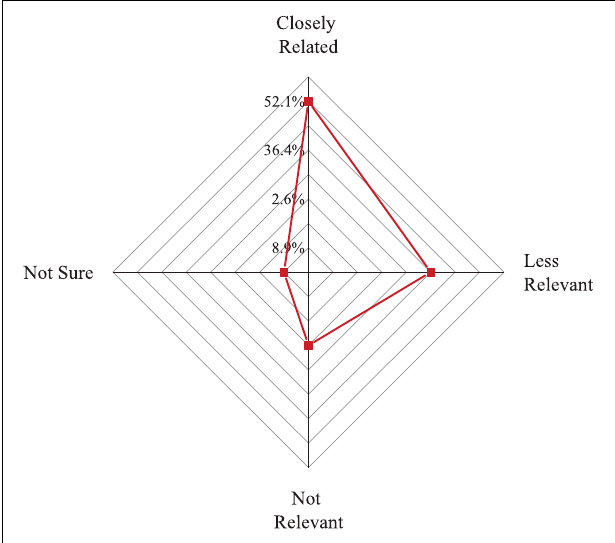
FIGURE 3 | Distribution of students’ cognition of the relevance between IEE and professional education.